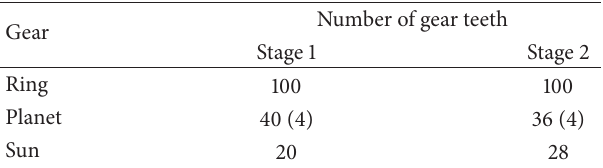
Table 2: Planetary gearbox configuration.